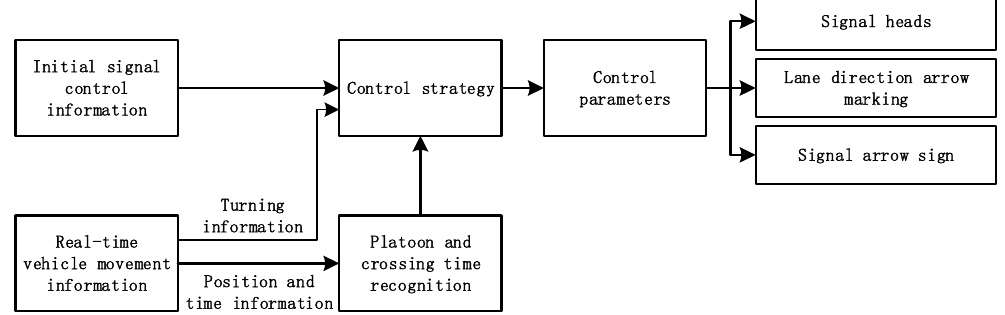
Figure 4. Block diagram of the control system.